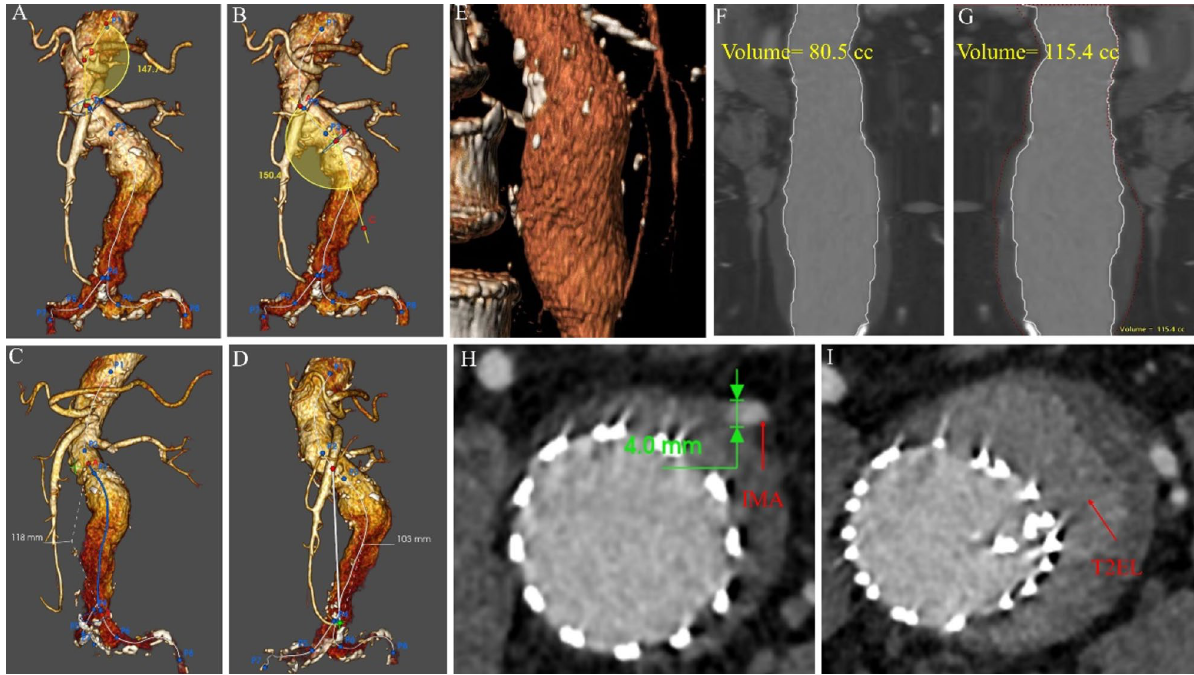
Figure 2. The morphological features of abdominal aortic aneurysm. ( A ) Angle (α) is defined as the angle between the central line of the upper abdominal aorta of the kidney and the central line of the lower abdominal aortic aneurysm neck. ( B ) Angle (β) is the angle between the aneurysm neck and the centerline of the aneurysm body. ( C ) L1 is defined as the length of the central line of the aneurysm. ( D ) L2 is defined as the length of the distance at the beginning to the end of the aneurysm. ( E ) The three-dimensional reconstruction of aneurysm sac by 3-Mensio software for estimating the proportion of thrombus. ( F ) The volume of blood in the aneurysm sac. ( G ) The volume of the whole aneurysm sac. ( H ) The diameter of the inferior mesenteric artery was measured by Endosize. ( I ) The occurrence of T2EL was identified by